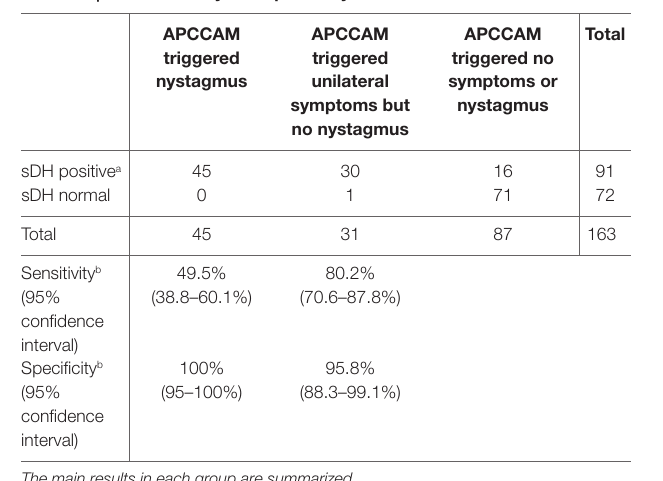
TaBle 1 | The sensitivity and specificity of the